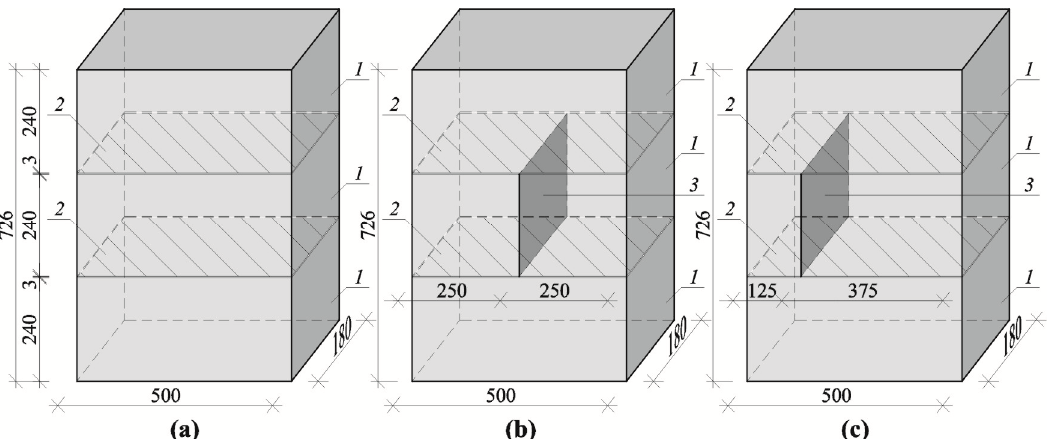
Figure 7. Geometry of models made of AAC tested in stage II (dimensions in mm): ( a ) models of series I without head joint, ( b ) models of series II with head joint at the mid-length of the element, ( c ) models of series III with head joint at 1 / 4 length; 1 —masonry units, 2 —bed joints, 3 —head joints.